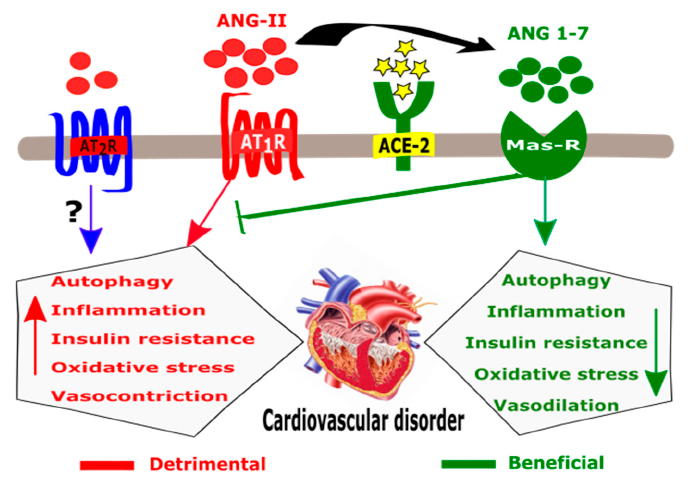
Figure 3. Schematic diagram for the major pathways in RAAS